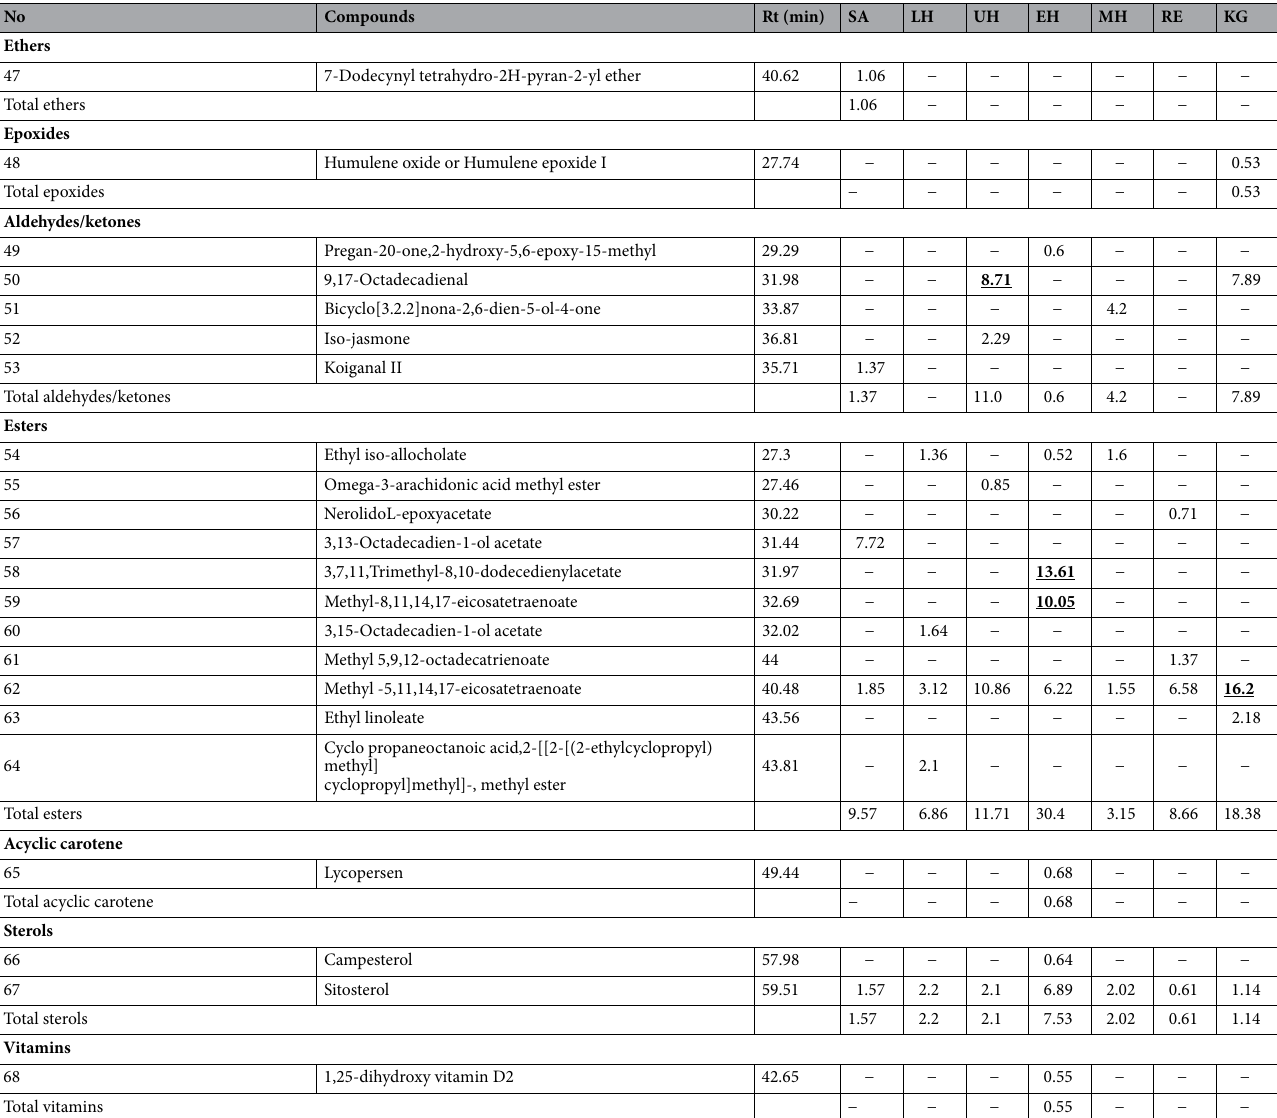
Table 2. Relative percentage of the un-saponified compounds in the studied avocado seed extracts using GC/MS. The main compounds for each species are underlined and bolded. The separation was performed